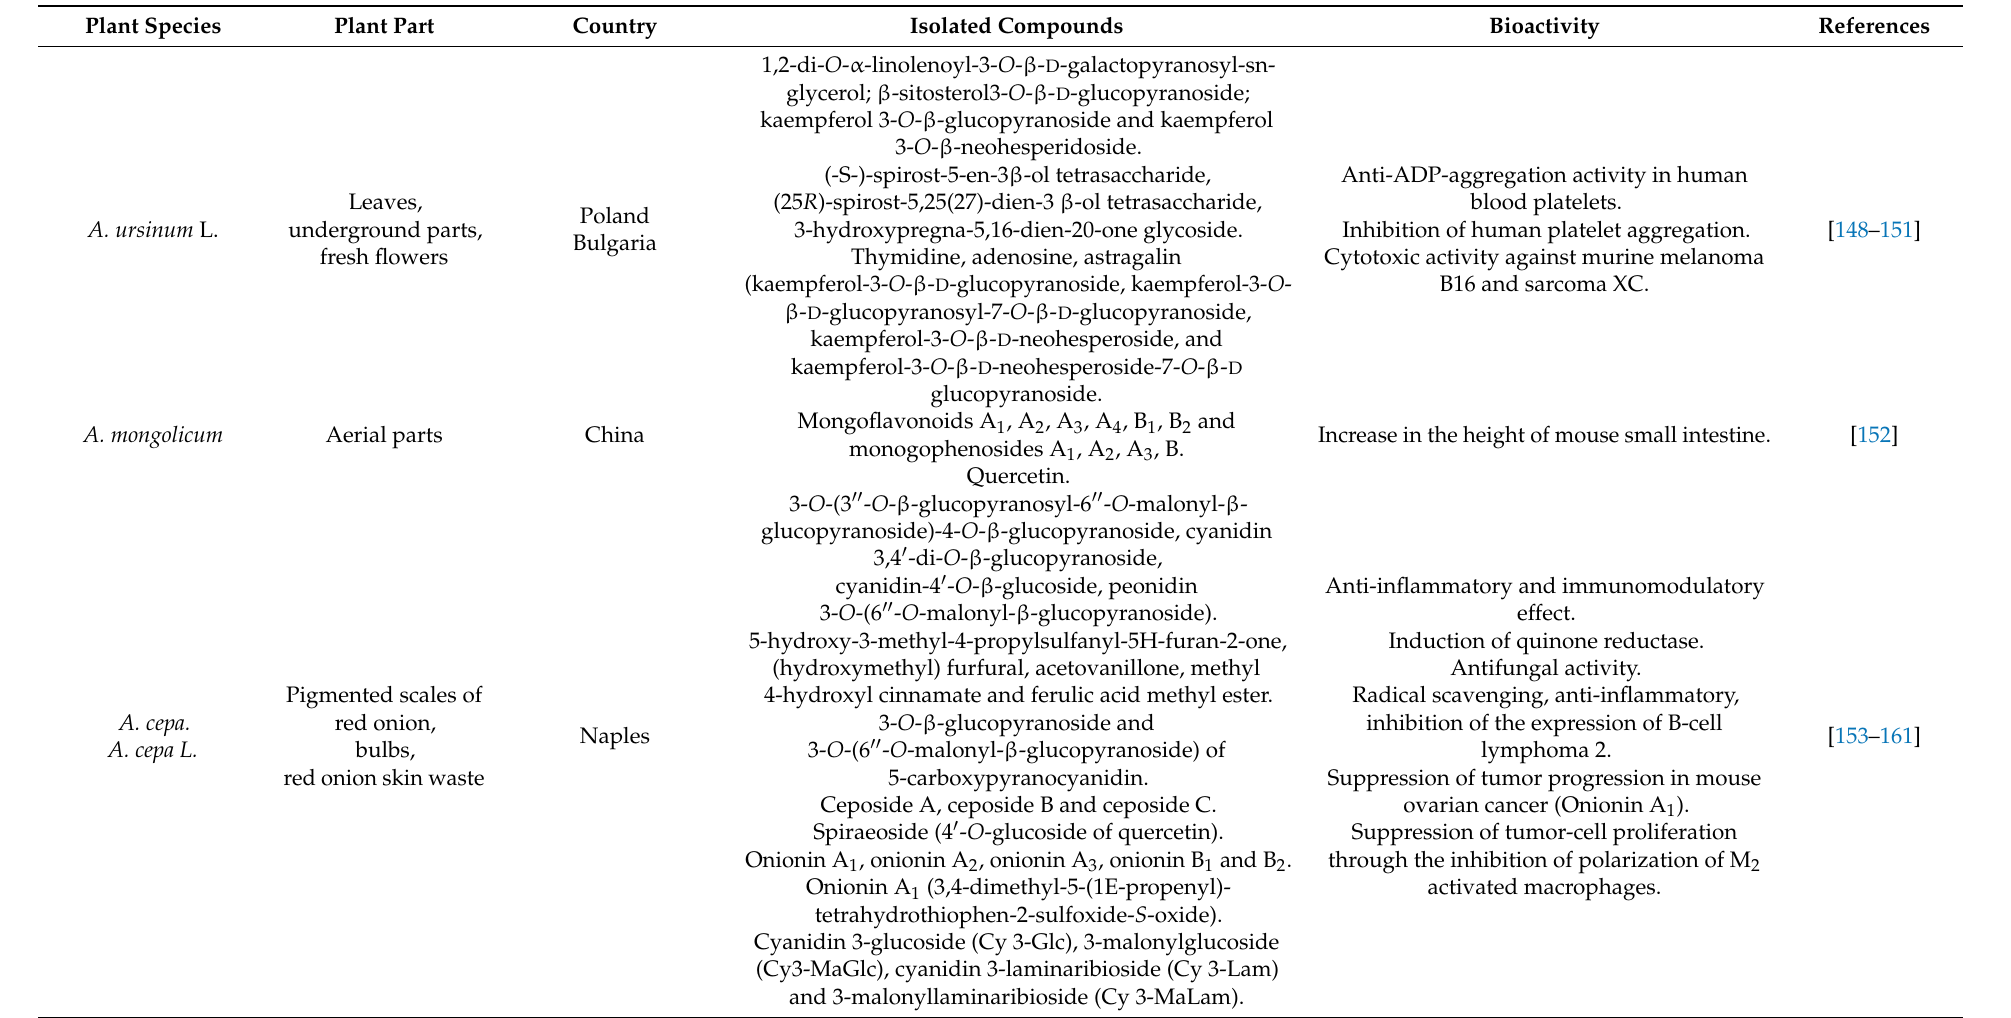
Table 10. Bioactive compounds isolated from Allium